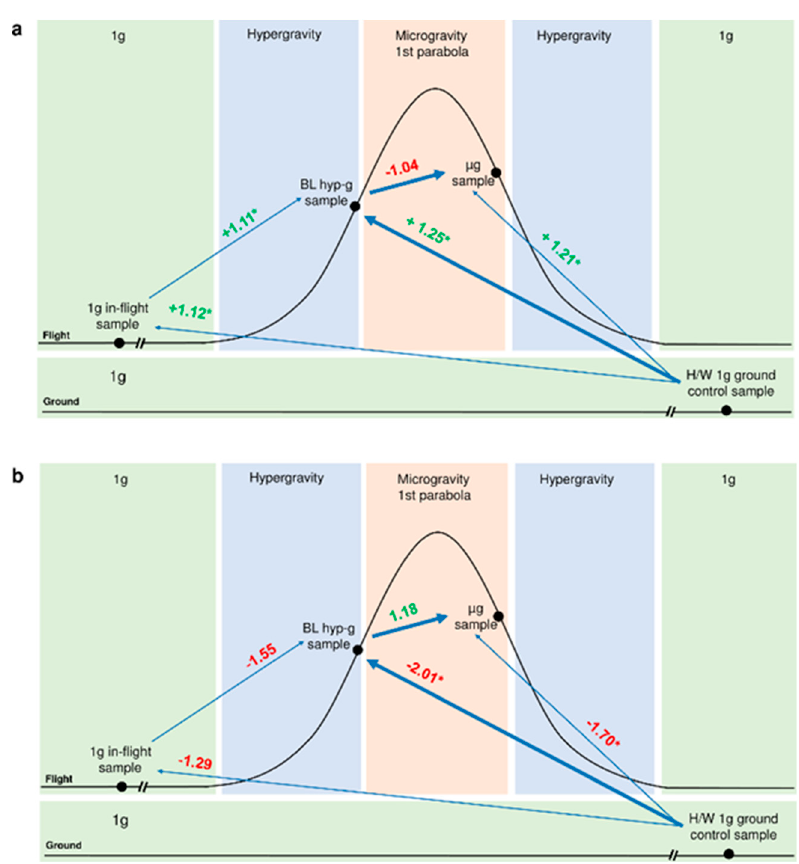
Figure 2. Differential gene expression of HIF-1 α in ( a ) human Jurkat T cells and ( b ) U937 cells after 20 s altered gravity on a parabolic flight. The gene expression regulation is displayed for inter-phase comparisons as fold change numbers next to the blue arrows connecting the compared experimental conditions. Shown are the RNA expression values for the comparisons: 1 g in-flight versus hardware (H/W) 1 g ground control, baseline/hypergravity (BL hyp-g) versus 1 g in-flight, BL hyp-g versus H/W 1 g ground control, microgravity ( µ g) versus BL hyp-g and µ g versus H/W 1 g ground control. For definition of the abbreviations of the conditions see also Table 1. (* p -value < 0.05, red = down-regulation, green = up-regulation).